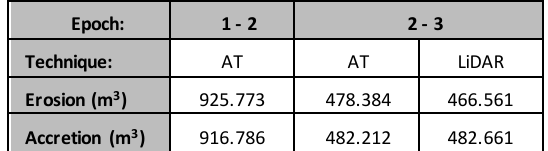
Table 8: Volume analysis of erosion & accretion between